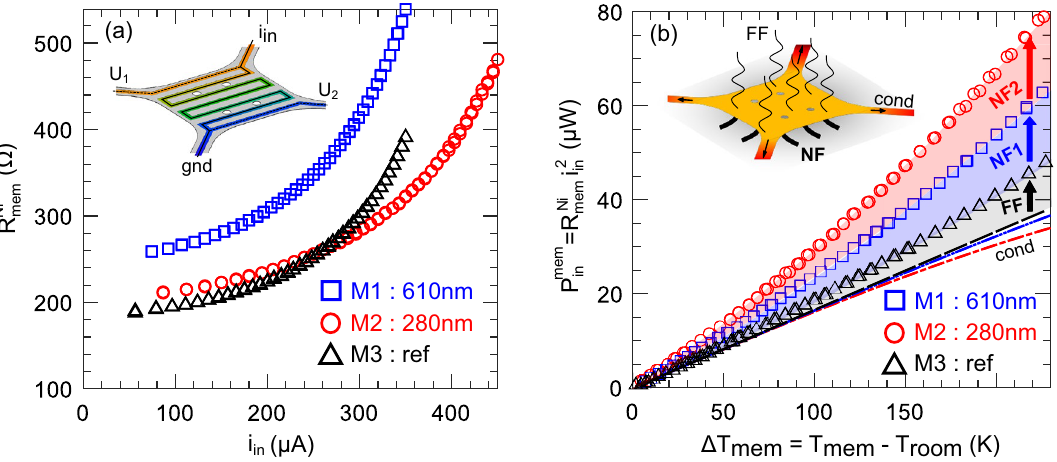
Figure 2. ( a ) Measured heater resistance as a function current for samples with nanometric gaps M1 (blue), M2 (red) and the reference sample M3 (black). Inset: electric potential distribution and the four-point probe measurement. ( b ) Measured input heating power as a function of the temperature increase in the membrane is shown by markers for samples M1 (blue), M2 (red) and M3 (black). Calculated thermal conduction through the legs is shown by the dashed lines. Increases in dissipated power from far-field (FF) and near-field (NF) thermal radiation are indicated by arrows. Inset: temperature distribution and heat fluxes